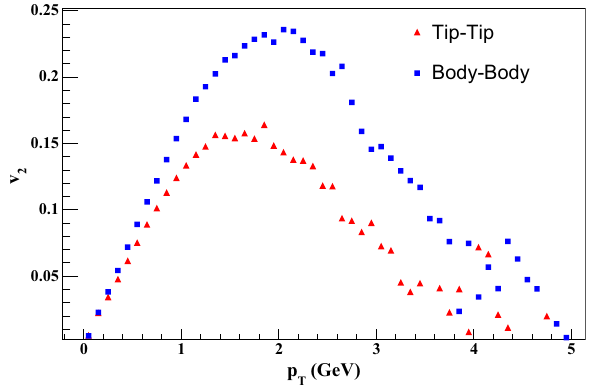
Fig. 23 Comparison of v 2 of charged hadrons with respect to p T in body–body and tip–tip configuration for most central collision. STAR data is taken from Ref. [14]